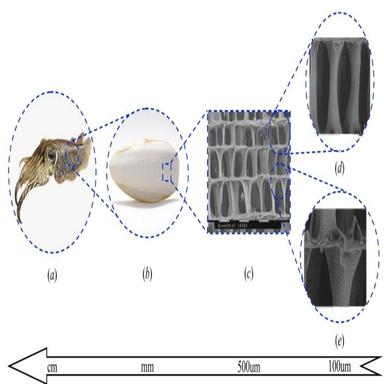
Cuttlebone and its microstructure: (a) cuttlefish (, accessed on 8 Mar 2020); (b) cuttlebone ((https://aquaticarts.com/products/cuttlebone) accessed on 8 Mar 2020); (c) microscope view of the cuttlebone; (d) magnification of the pillars (; (e) diaphragms supported by pillars.